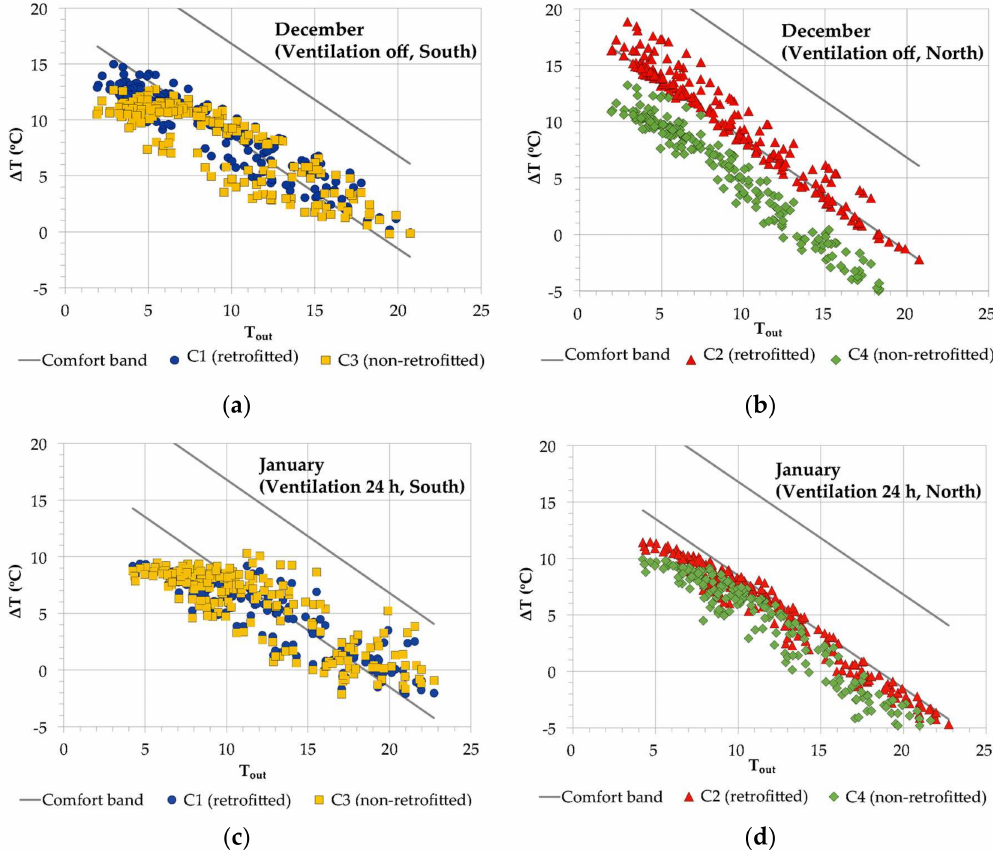
Figure 13. Dispersion diagrams. December protocol: ( a ) south cells; and ( b ) north cells. January protocol: ( c ) south cells; and ( d ) north cells.